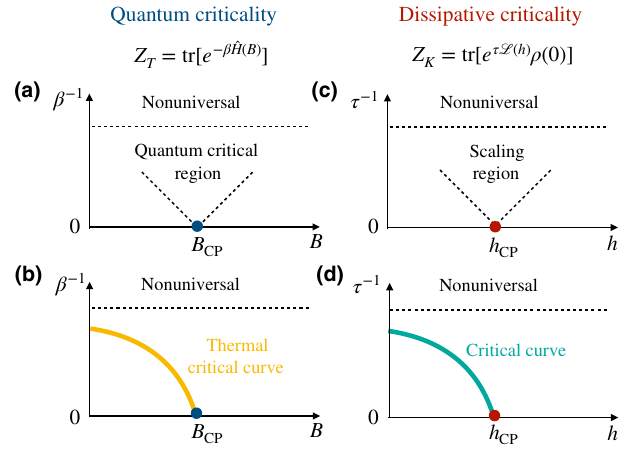
FIG. 7. Scenarios of quantum CPs and dissipative CPs. (a) The critical properties of a quantum CP extends to a quantum critical region characterized by a nonzero temperature β − 1 > 0, which can be captured by scaling laws such as Eq. (A4). (b) A quantum CP as the end point of a thermal critical curve. In this case simple scaling laws such as Eq. (A4) may fail to describe the physics at a nonzero temperature β − 1 > 0. (c)–(d) Analogous situations for dissipative CPs. For dissipative CPs, the scaling variable is not the temperature β − 1 , but the inverse evolution time τ − 1